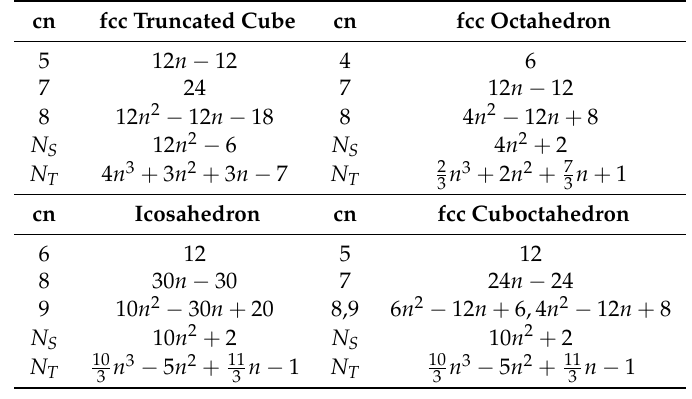
Table 2. Bond strength parameters for platinum, where R 2 is the least squares regression.